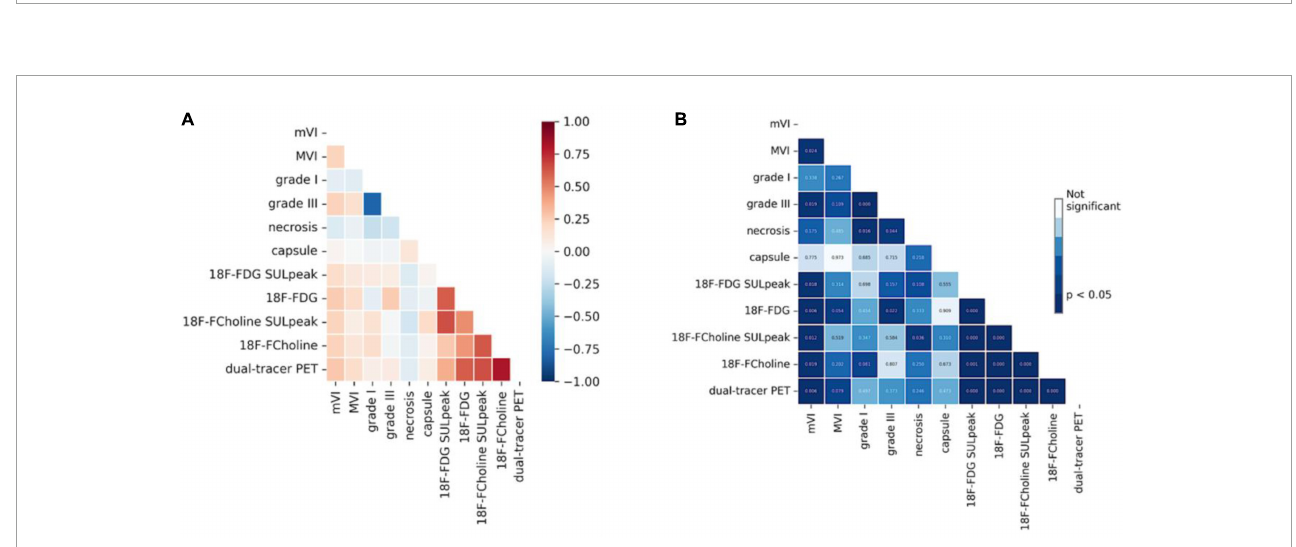
FIGURE4 Heatmap of the correlations between histological and positron emission tomography (PET) metrics (Spearman’s rank correlation). (A) Spearman ρ coefficients between histological characteristics of hepatocellular carcinoma (HCC) and PET uptake positivity. (B) Corresponding p -values Here, only the mVI and Grade III were significantly correlated to the PET